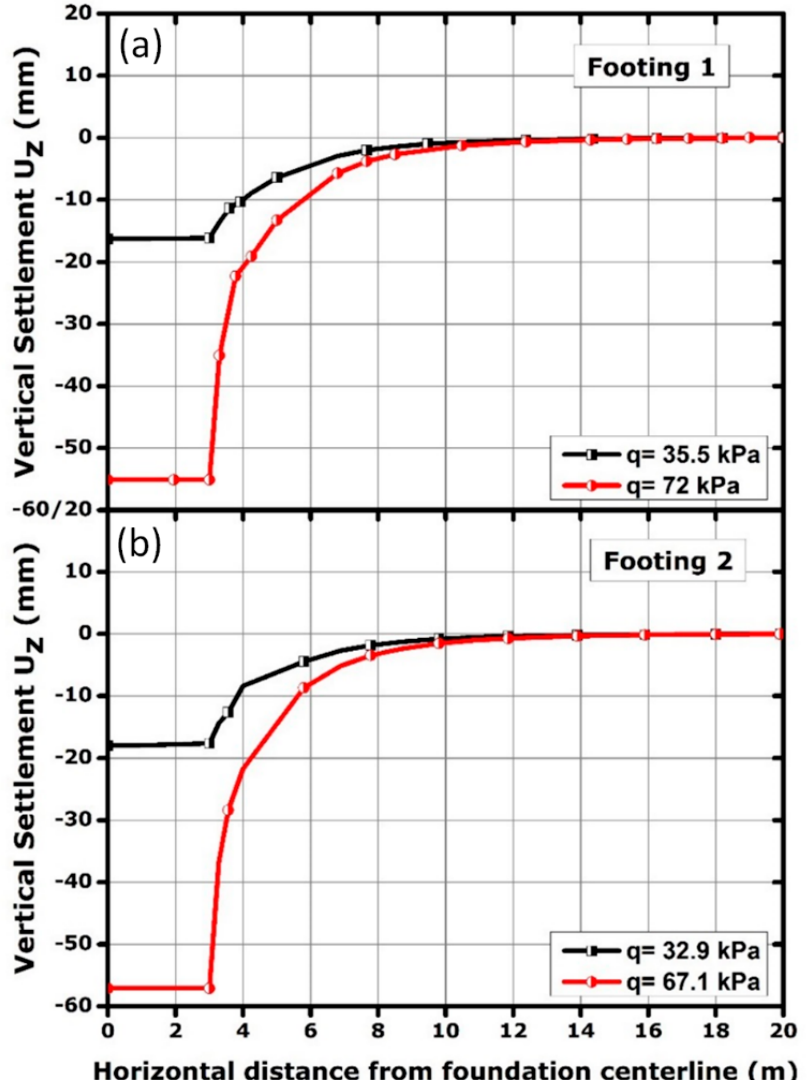
Figure 7. Influence of column spacing on the footing and ground surface settlement in drained conditions ( a ) Footing 1; ( b ) Footing 2.